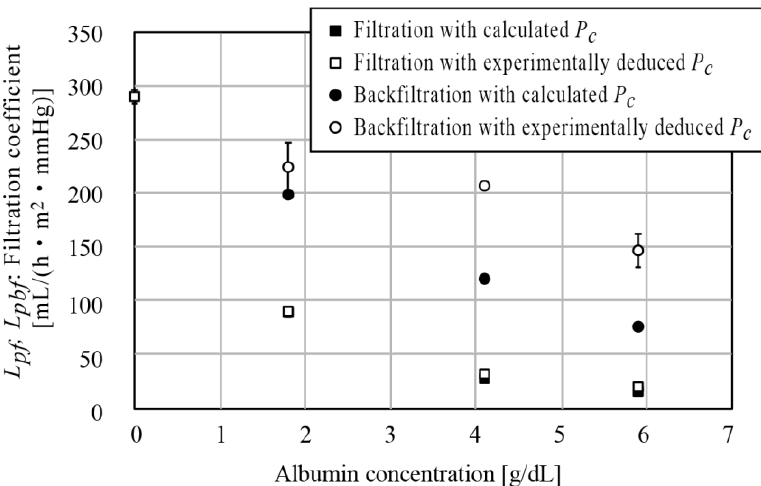
Figure 7. Filtration coefficients 𝐿 𝑝𝑓 and 𝐿 𝑝𝑏𝑓 with respect to albumin concentration. The calculated 𝑃 𝑐 and experimentally deduced 𝑃 𝑐 had discrepancy, which led to the discrepancy particularly for 𝐿 𝑝𝑏𝑓 . Both coefficients decreased with albumin concentration due to fouling. 𝐿 𝑝𝑏𝑓 was found to be larger than 𝐿 𝑝𝑓 and the discrepancy increased with increasing concentration.